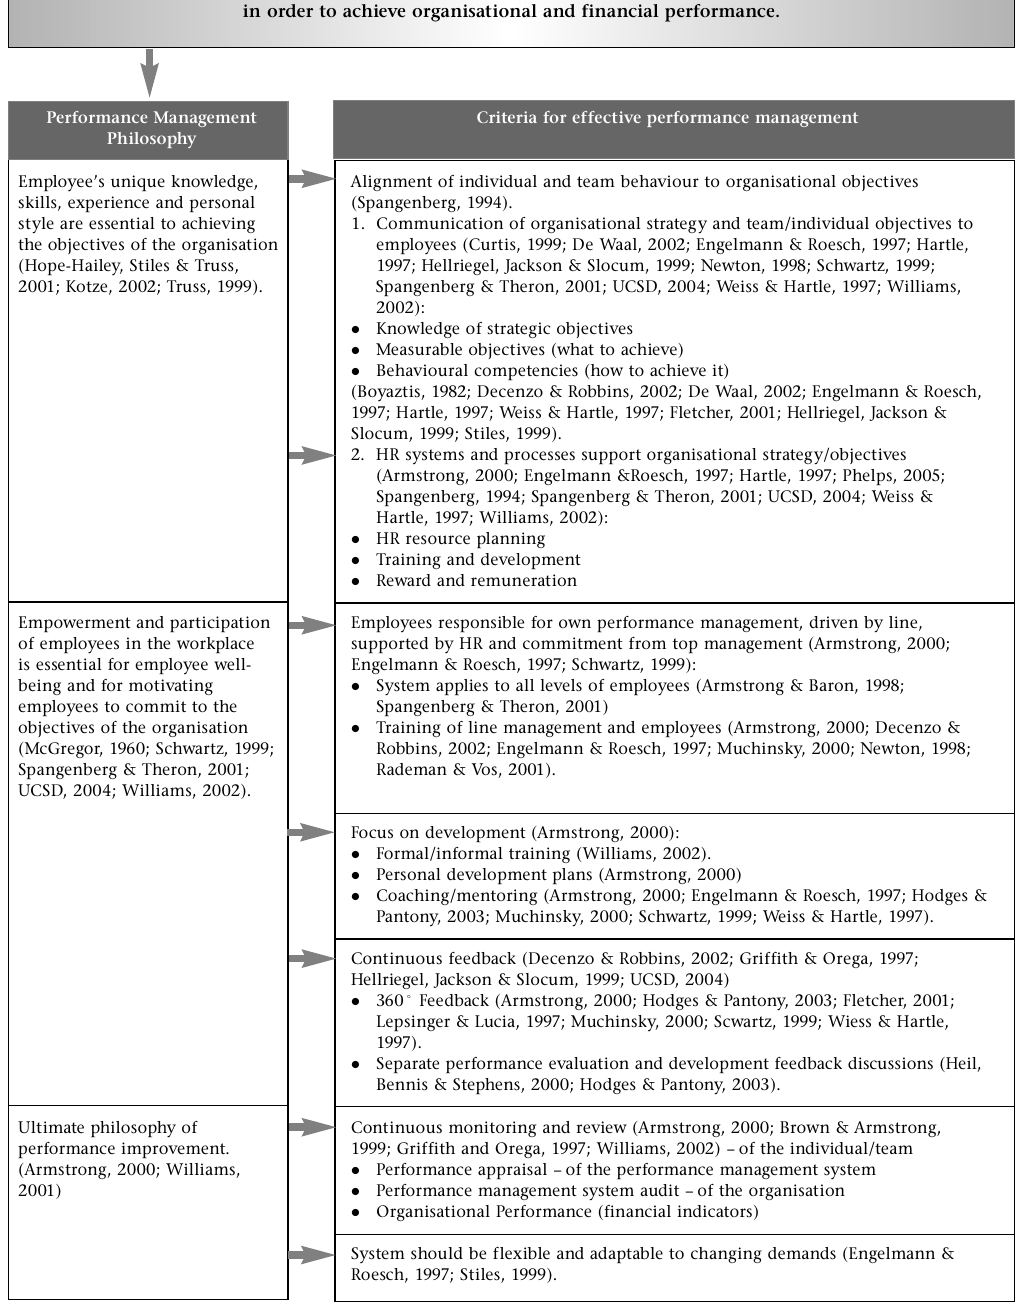
Figure 2: A philosophical model of performance management and criteria for